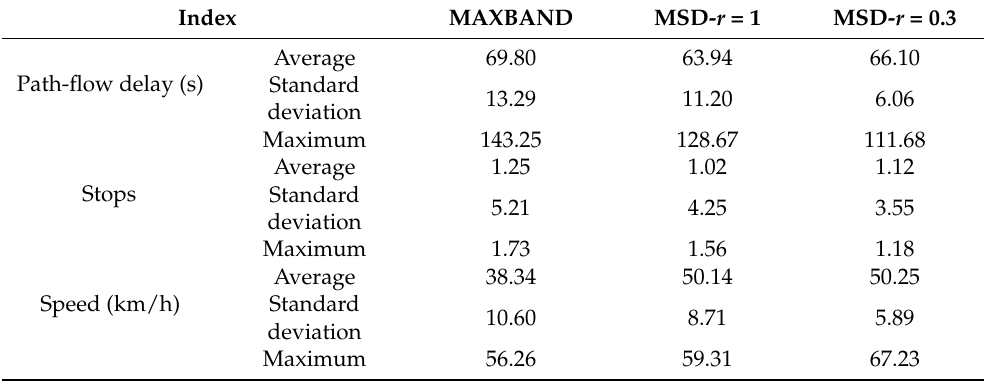
Figure 12. Spatial ‐ temporal variation of green bands obtained by flow uncertainty (MSD ‐ r = 0.3). Figure 12. Spatial-temporal variation of green bands obtained by flow uncertainty (MSD- r = 0.3). Table 3. Arterial performance under the control of different